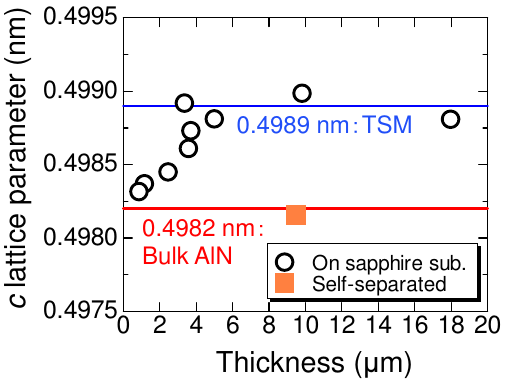
Figure 1. Dependence of the c lattice parameter on thickness.